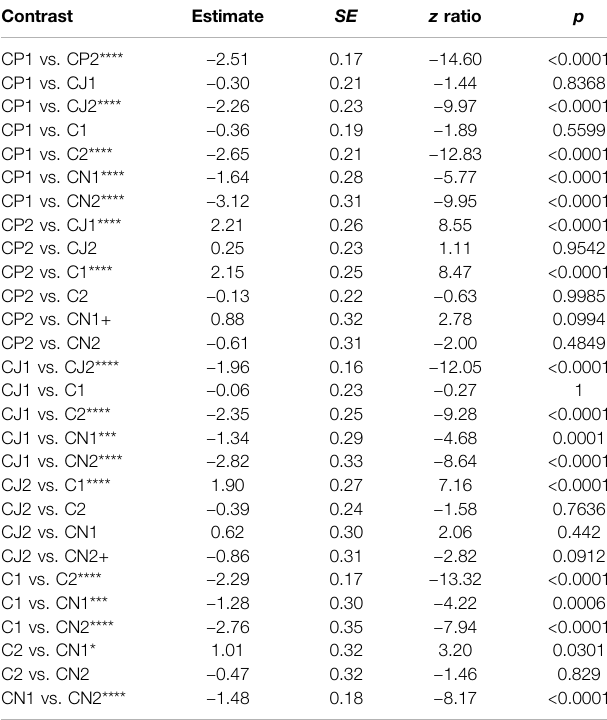
TABLE 7 | Mean proportions and standard deviations ( SD s) in learning condition retrieval tasks. CP CJ C CN